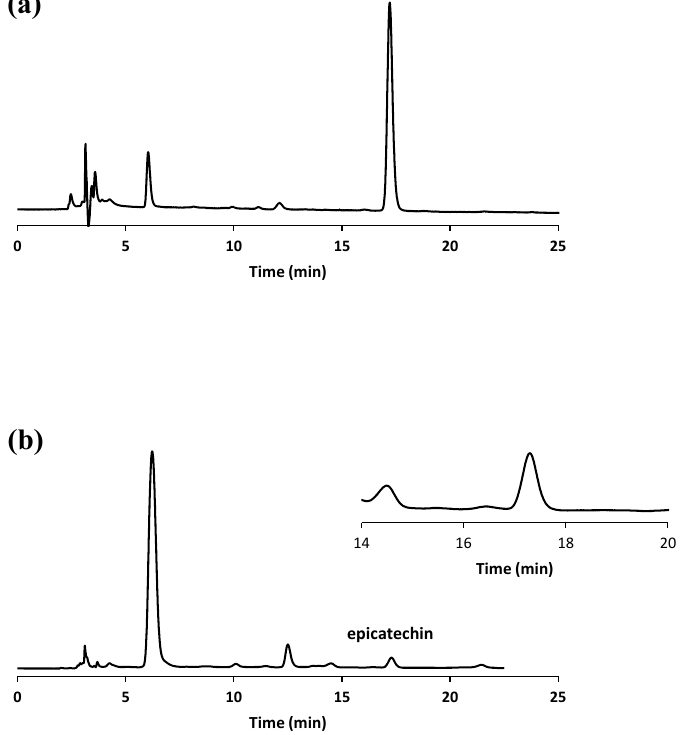
Figure 1. Representative HPLC chromatograms of ( a ) (-)-epicatechin standard solution and ( b ) an extracted sample (the magnified section of the chromatogram in the time-window containing epicatechin is highlighted).